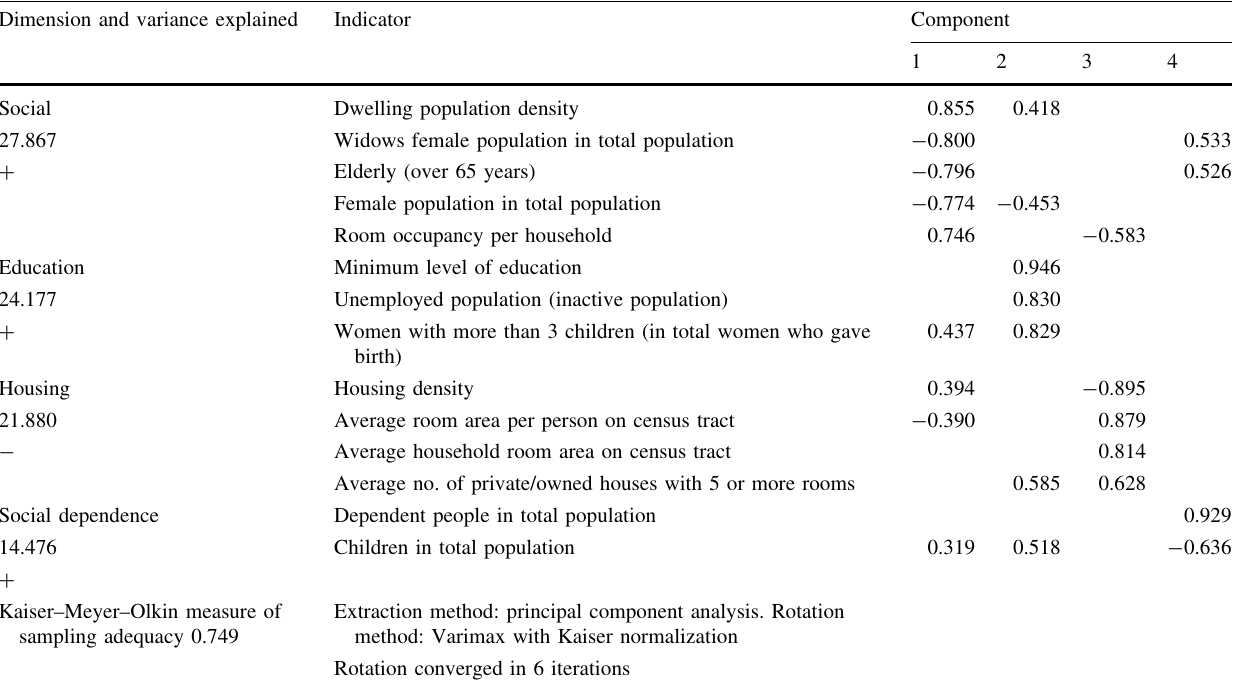
Table 2 Social vulnerability dimensions and loadings of variables on the components. Source Armas¸ and Gavris¸ (2016) Dimension and variance explained